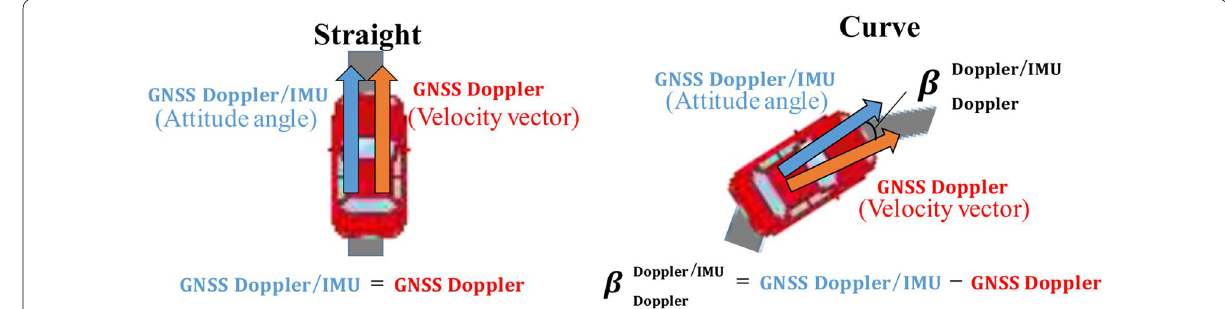
Fig. 6 Overview of the slip